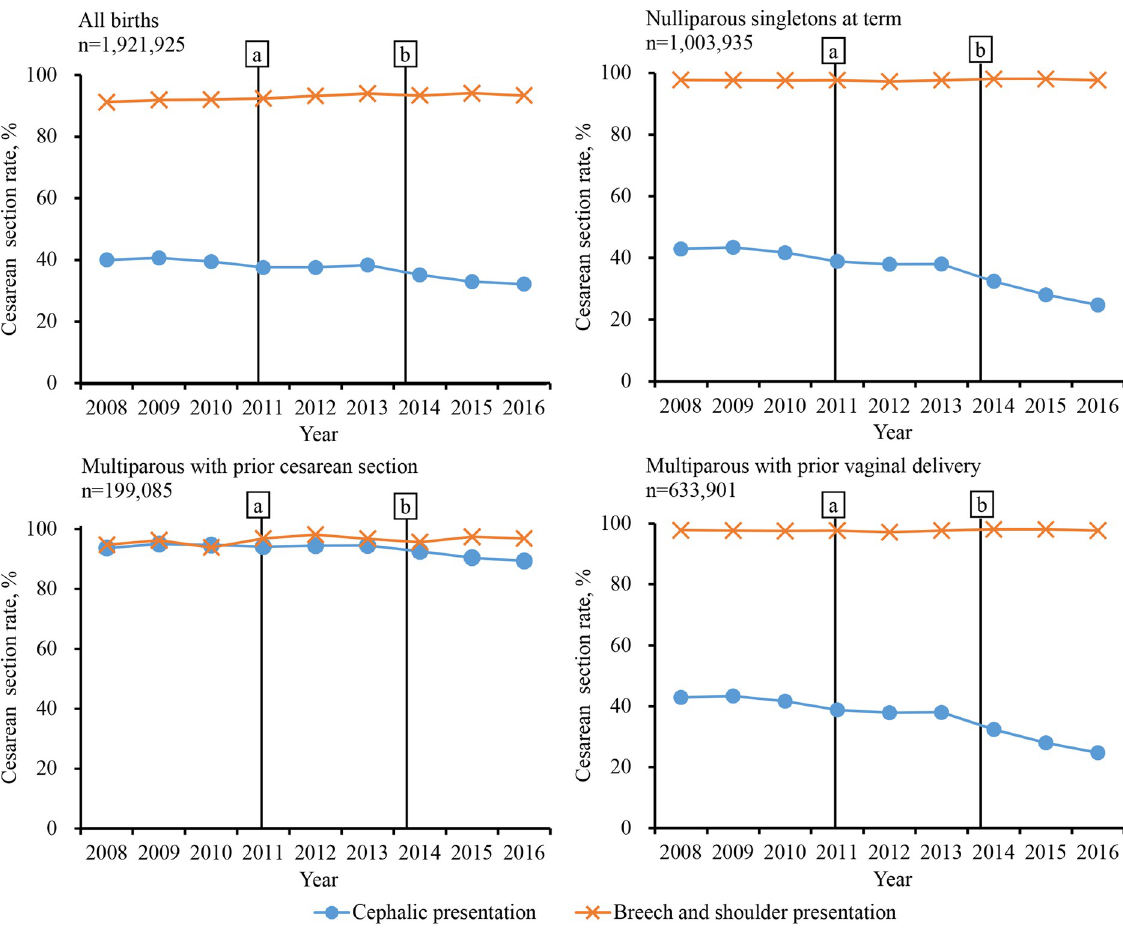
Fig 3. Trends of yearly fetal presentation-specific CS rates among all births and by parity and prior delivery mode in Guangzhou, China, 2008–2016. Baseline: from January 2008 to September 2010; Stage 1: from October 2010 (Point “a”) to September 2014; Stage 2: from October 2014 (Point “b”) to December 2016. CS, cesarean